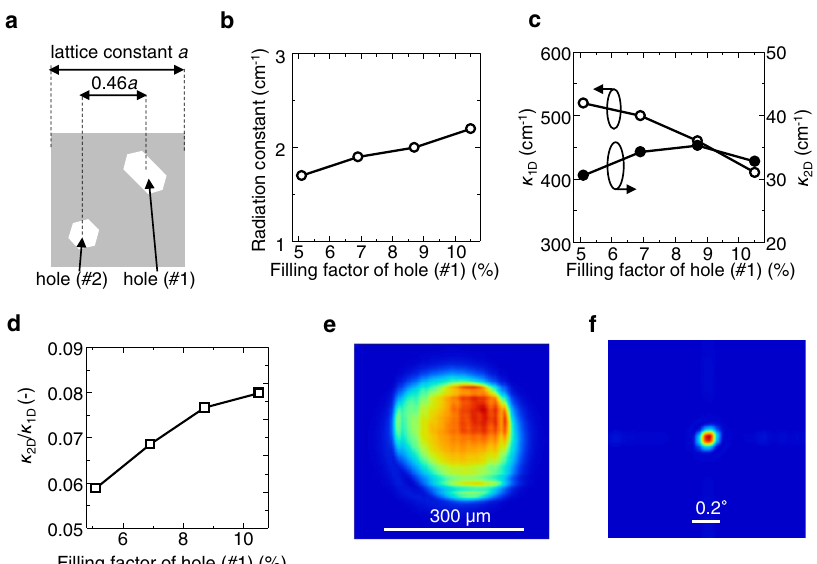
Fig. 4 Design of a double-lattice photonic crystal and calculation of α v , κ 1D , κ 2D , near- fi eld pattern and far- fi eld pattern by 3D-CWT. a Schematic of a designed double-lattice photonic crystal. b Calculation of radiation constant α v versus FF of hole (#1). c Calculation of 1D coupling coef fi cient κ 1D and 2D coupling coef fi cient κ 2D versus FF of hole (#1). d Ratio κ 2D / κ 1D versus the FF of hole (#1). e Calculation of the NFP of a double-lattice structure using a FF of 10.5% for hole (#1) and 3.5% for hole (#2). f Calculation of the FFP of a double-lattice structure using a FF of 10.5% for hole #1 and 3.5% for hole